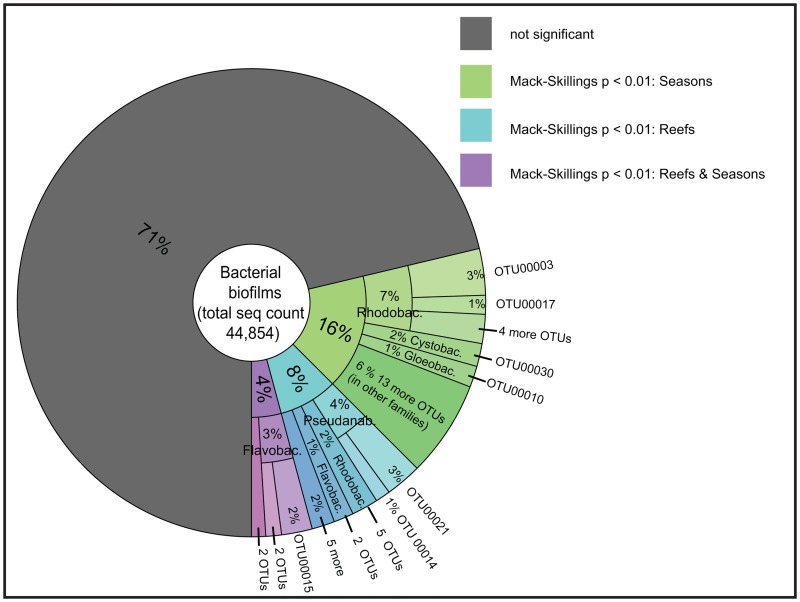
Proportions of differentially abundant bacterial OTUs between reefs and seasons.(Rhodobac. = Rhodobacteraceae; Cystobac. = Cystobacterineae; Gloeobac. = Gloeobacteraceae; Pseudanab. = Pseudanabaenaceae; Flavobac. = Flavobacteriaceae).